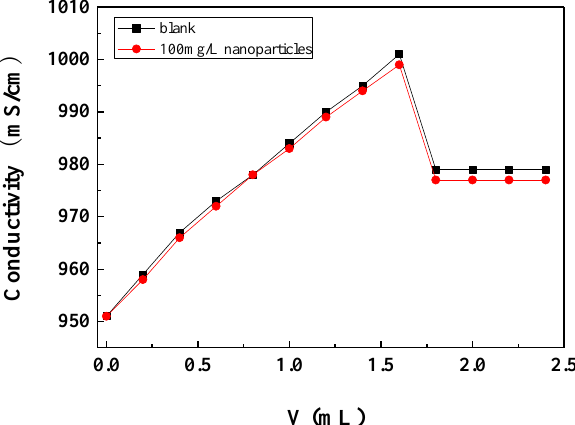
Figure 6. The conductivity changes with the addition amount of Na 2 CO 3 solution in the scale-forming